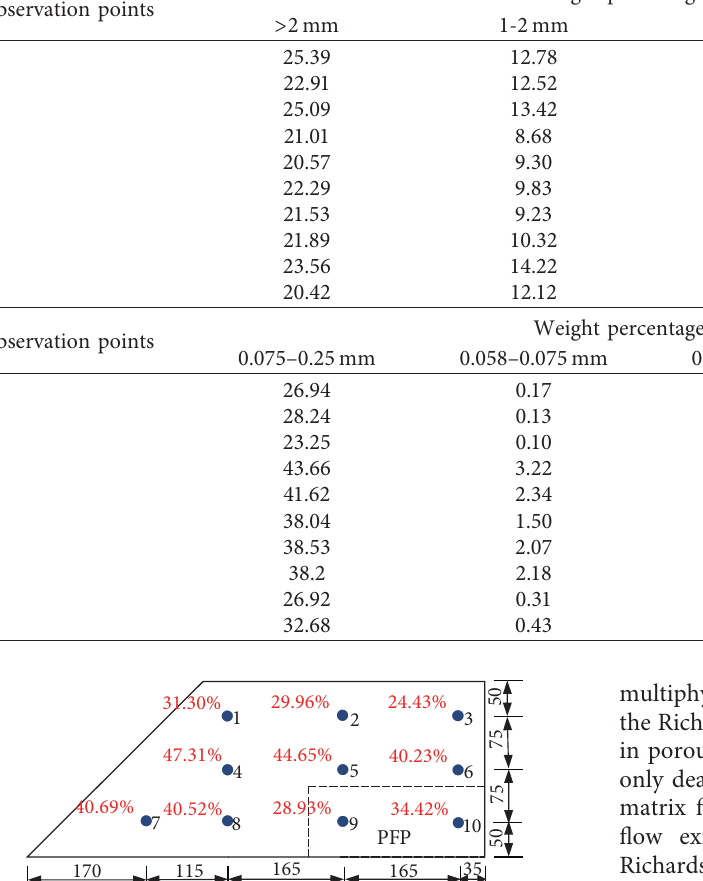
Table 1: Particle gradation of the rare earth particles at each observation point after leaching. Observation points